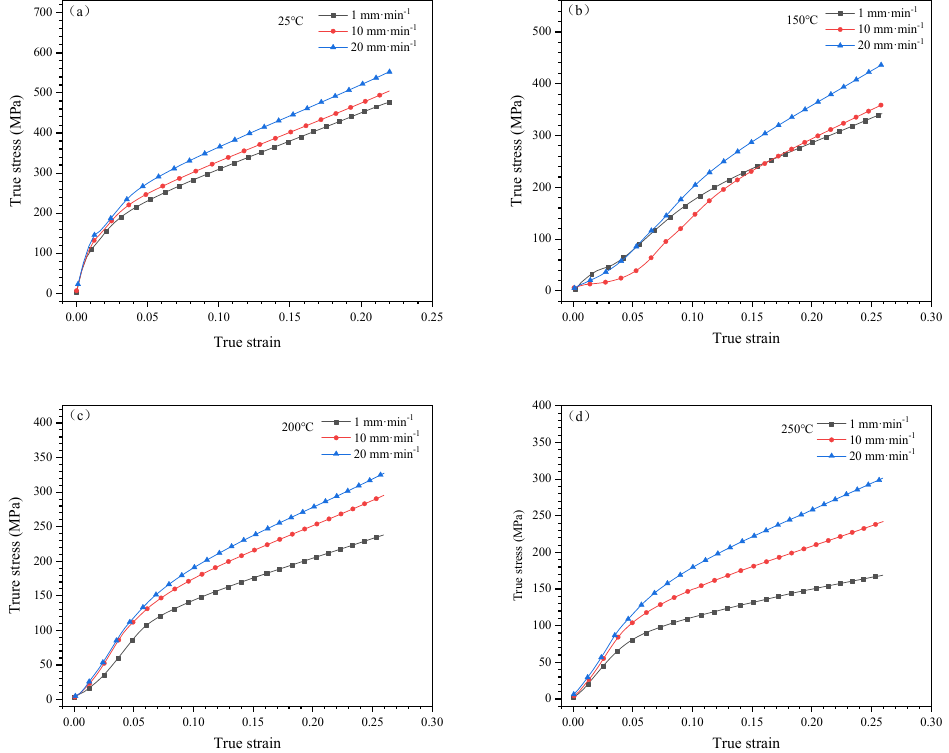
Figure 4. The true stress and true strain of AZ31B under the different strain rates at each experiment temperature. ( a ) at 25 °C; ( b ) 150 °C; ( c ) at 200 °C; ( d ) at 250 °C.